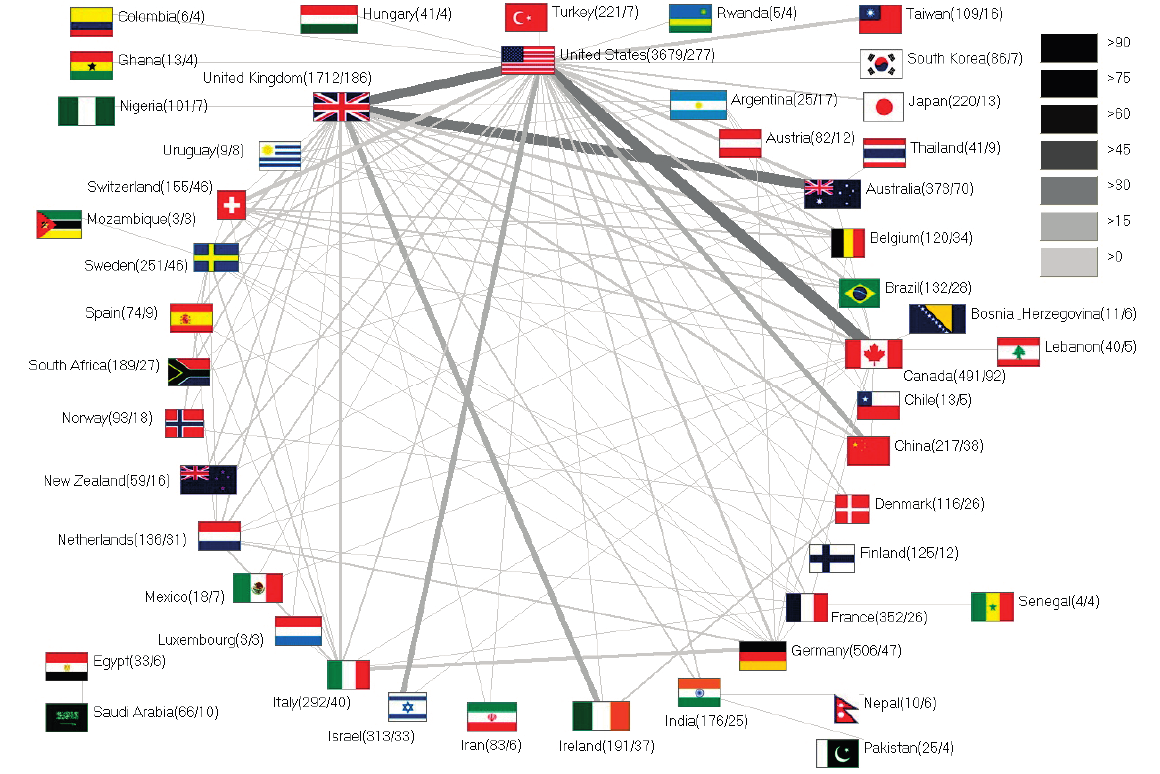
Figure 4. Net diagram of international cooperations. Line width and grey scale encode numbers of collaborations. Numbers in brackets (number of publications of a specific country/number of collaboration articles of a specific